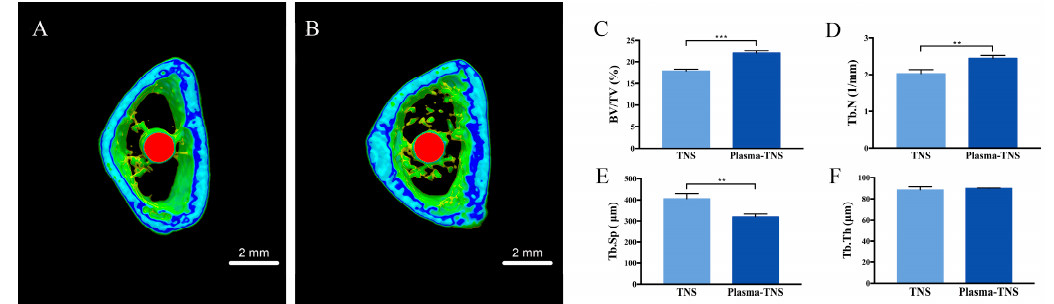
Figure 7. Reconstructed three-dimensional microcomputed tomography transverse slices of rat femurs containing TNS ( A ) and plasma-TNS ( B ) implants. The implant, cortical bone, and cancellous bone are shown in red, blue, and green, respectively. ( C ) Bone volume to total volume ratio (BV/TV), ( D ) mean trabecular number (Tb.N), ( E ) mean trabecular separation (Tb.Sp), and (F) mean trabecular thickness (Tb.Th) around implants after eight weeks. Data shown are the means ± SD ( n = 3). *** p < 0.001; ** p < 0.01.